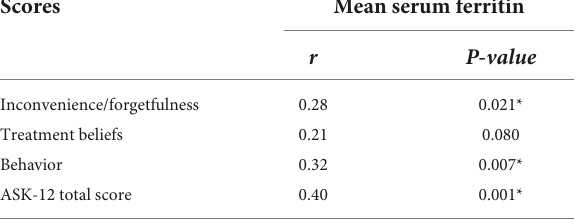
TABLE 2 Correlation between ASK-12 and its subscales with mean serum ferritin